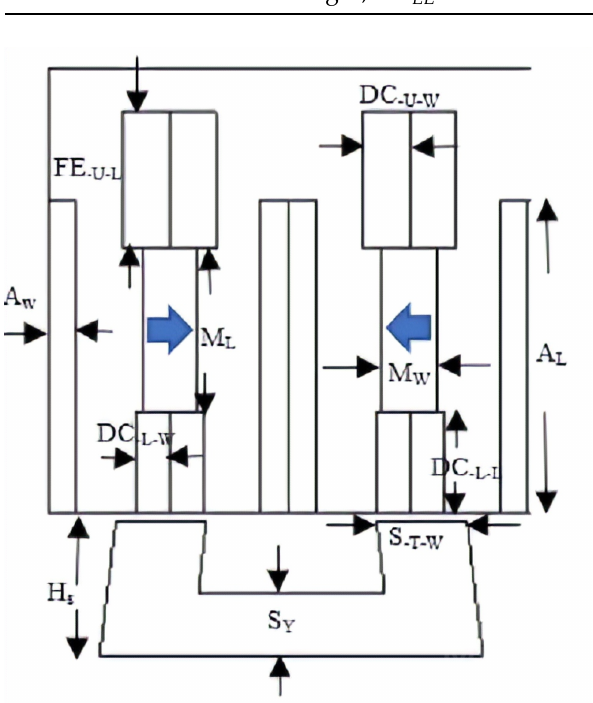
Figure 3. Parameters of the proposed